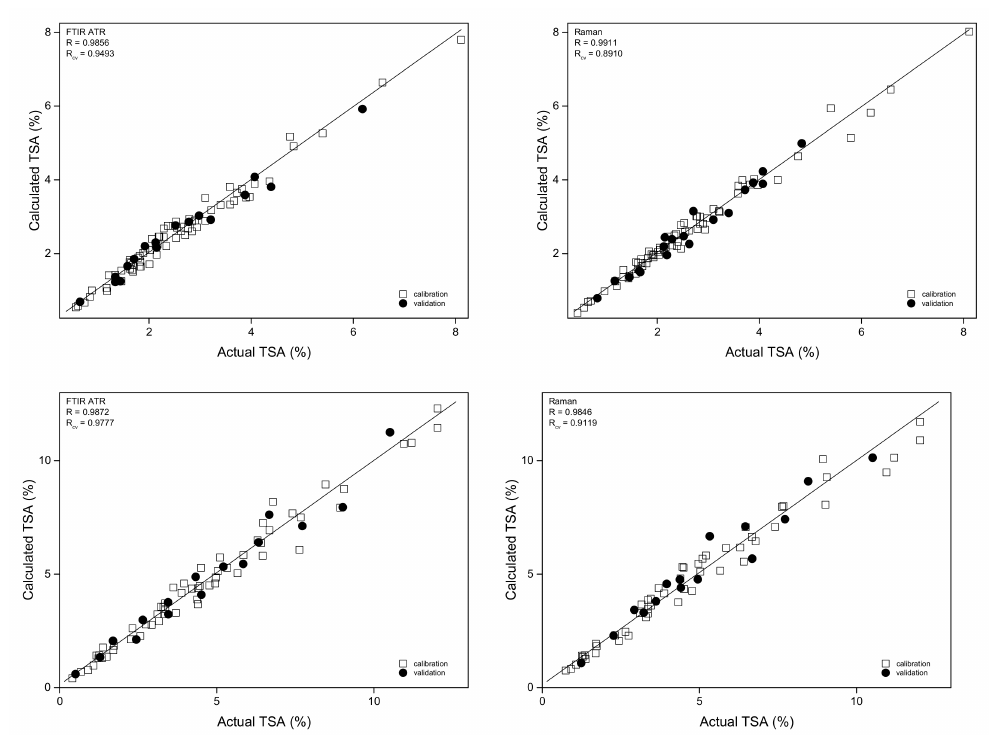
Figure 7. Prediction plots for the TSA content modeling in the bark ( top ) and leaves ( bottom ) on the basis of ATR ( left ) and Raman ( right )